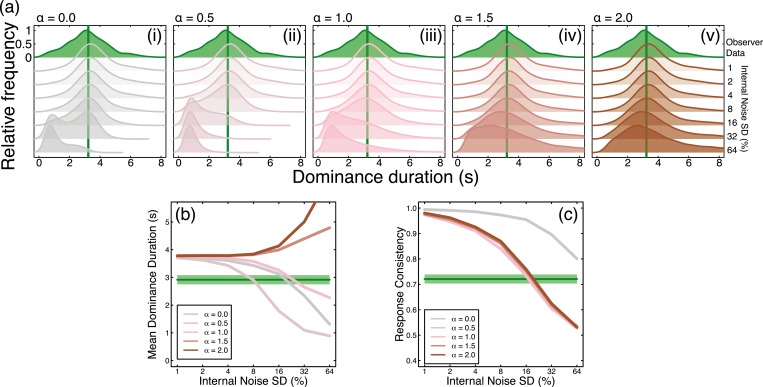
Summary of model behaviour for internal noise amplitude and spectral slope estimation.(a) The histograms of dominance durations for each spectral slope (ɑ = 0.0–2.0) and level of internal noise (SD = 1%– 64%). Within each subplot, the uppermost (green shaded) histogram shows the equivalent human data for a stimulus temporal frequency of 1/8Hz and a contrast modulation of SD = 16%. The solid vertical green line marks the average dominance duration for human observers. Histograms below show model dominance duration distributions for each internal noise level. (b) Average dominance durations of the model for each spectral slope (coloured lines). The green line and shaded area mark human average dominance duration and ±1SE of the mean, respectively. Average dominance duration was affected by internal noise once its standard deviation was equivalent to 4% contrast. Noise with steeper slopes (ɑ = 1.5–2.0) increased mean dominance duration as a function of noise contrast, while noise with shallower slopes decreased mean dominance duration. (c) Response consistency decreased as a function of internal noise contrast for all spectral slopes. The green line and shaded area mark human observer average consistency and ±1SE of the mean, respectively. For all ɑ>0, response consistency reached human levels at an internal noise contrast of 16%.